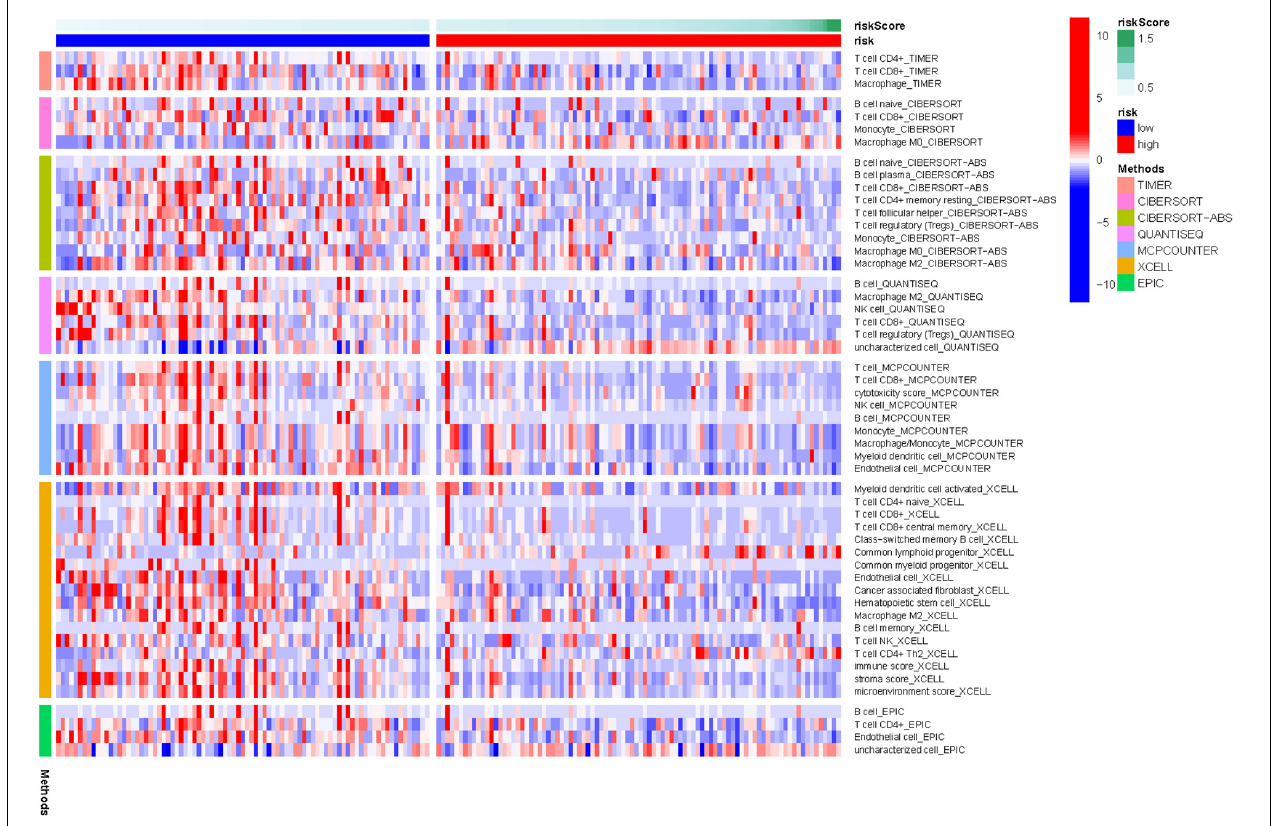
FIGURE 5 | Heatmap for immune responses based on TIMER 2.0 algorithms in pancreatic cancer between the high- and low- risk groups.